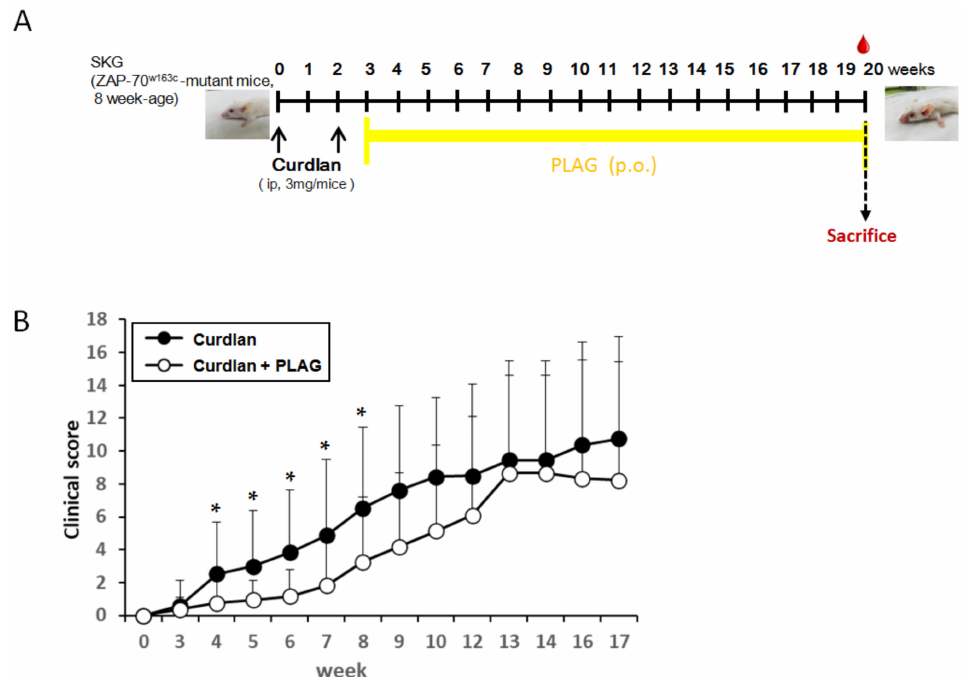
Figure 1. Experimental design and the clinical score of peripheral arthritis. ( A ) Experimental design. Eight-week-old male SKG mice were intraperitoneally injected with 3 mg curdlan at 0 and 2 weeks. The arthritis scores were measured every week for up to 17 weeks. In half of the curdlan- induced SKG mice, PLAG was orally administered from 3 weeks to 20 weeks after the curdlan injection. We identified the presence of ILD by a histological analysis at 20 weeks post-injection. ( B ) The clinical score of peripheral arthritis. The arthritis scores were significantly lower in the PLAG- treated curdlan-induced SKG mice, beginning 1 week after PLAG administration. The reduced scores continued significantly until 8 weeks after the first curdlan injection. The data are indicated as a mean ± SD; * p < 0.05. ip: intraperitoneal injection; ILD: interstitial lung disease; PLAG: acetylated diacylglycerol